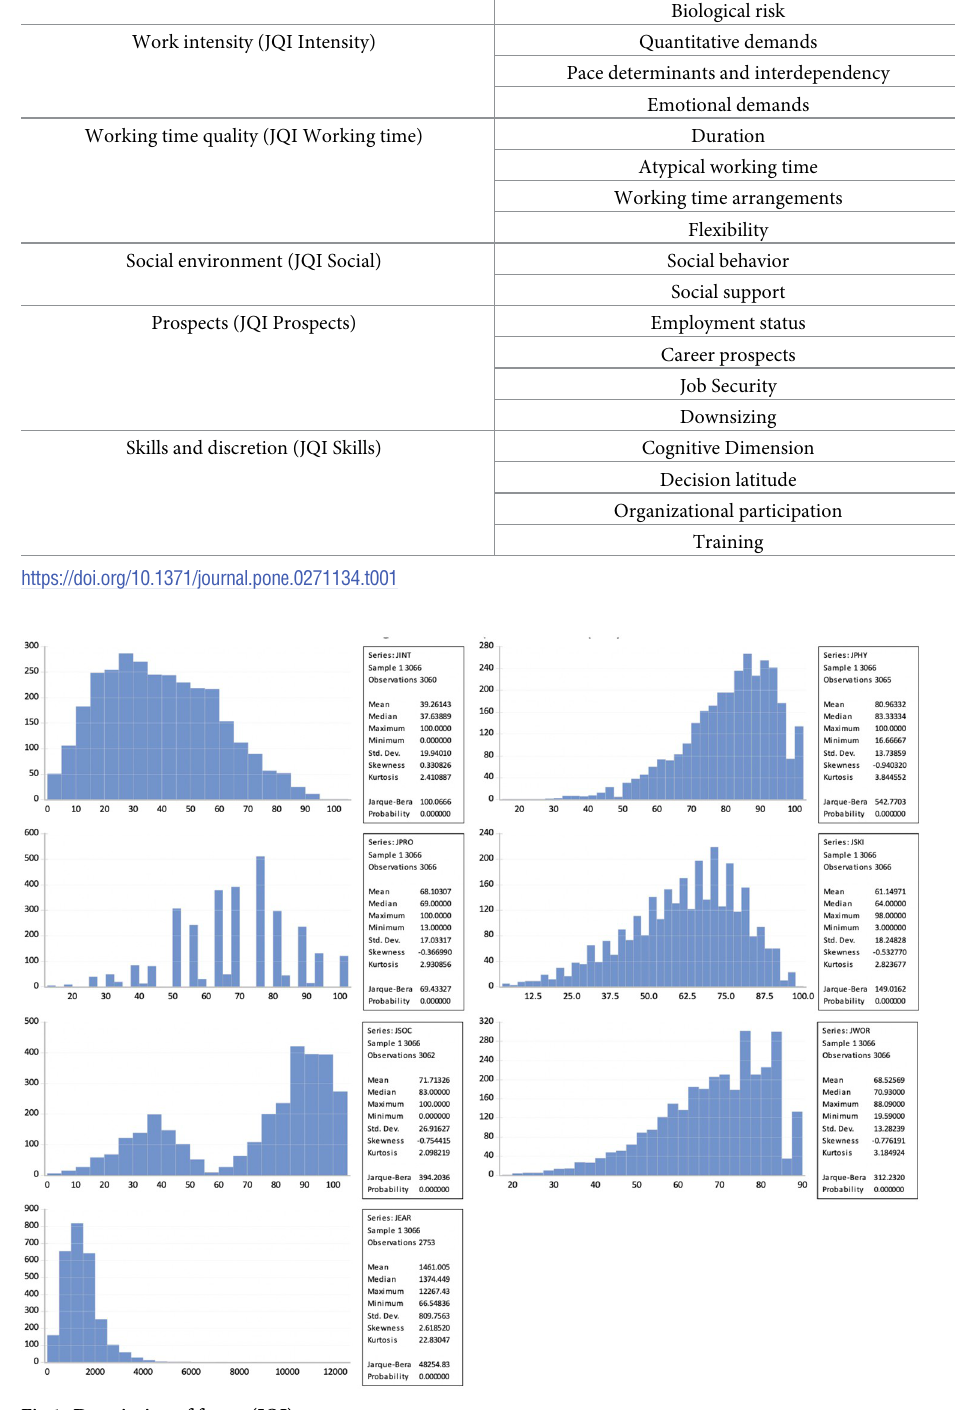
Fig 1. Description of factor